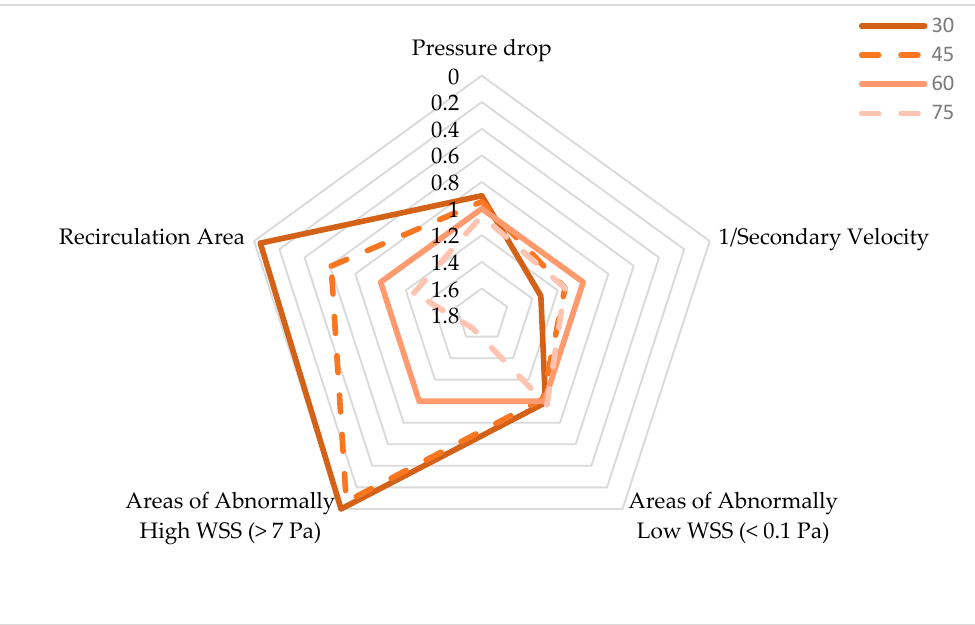
Figure 13. Comparison of hemodynamic performance resulting from bypass grafts of varying anastomosis angles.